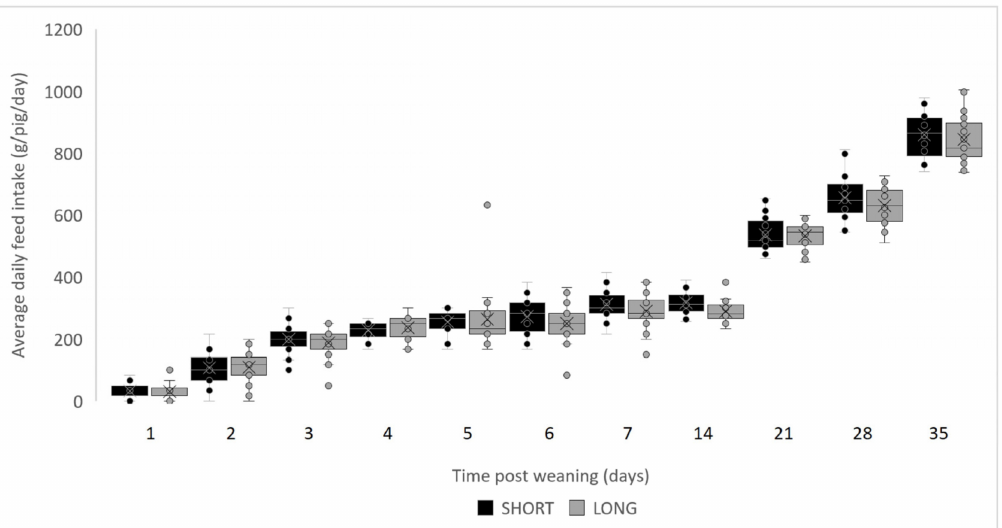
Figure 1. Average daily feed intake for SHORT (black, 8 h light and 16 h dark) and LONG (grey, 16 h light and 8 h dark) groups, daily for the first week ( p treatment = 0.507, p day < 0.001) and